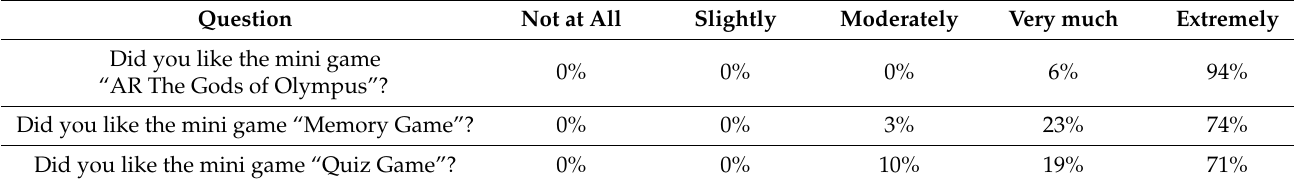
Table 5. Evaluation of the mini games.